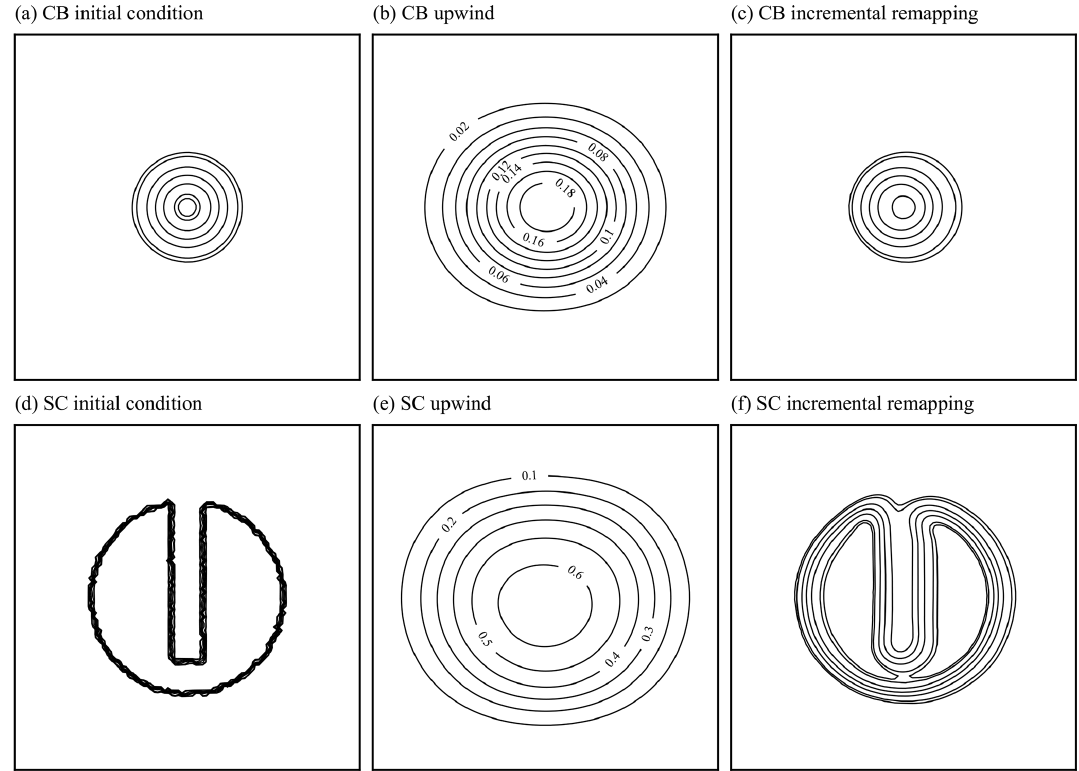
Figure 16. Initial (a, d) and final (b, c, e, f) ice concentration contours at 120km resolution for the cosine bell (a–c) and slotted cylinder (d–f) advection test cases. Results for the upwind advection scheme are shown in (b) and (e) , while results from the incremental remapping scheme are shown in (c) and (f) . Contours are at levels 0.05, 0.1, 0.3, 0.5, 0.7, 0.9, and 0.95 unless otherwise shown. The direction of transport is to the right.